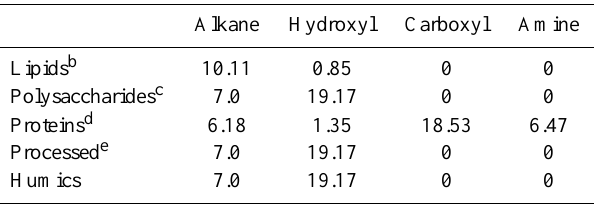
Table 4. Conversion from moles of carbon per macromolecule class to the mass associated with FTIR-observable functional groups, ((grams of the functional group) / (moles of carbon per macromolecule)) a . Alkane Hydroxyl Carboxyl Amine Lipids b 10.11 0.85 0 0 Polysaccharides c 7.0 19.17 0 0 Proteins d 6.18 1.35 18.53 6.47 Processed e 7.0 19.17 0 0 Humics 7.0 19.17 0